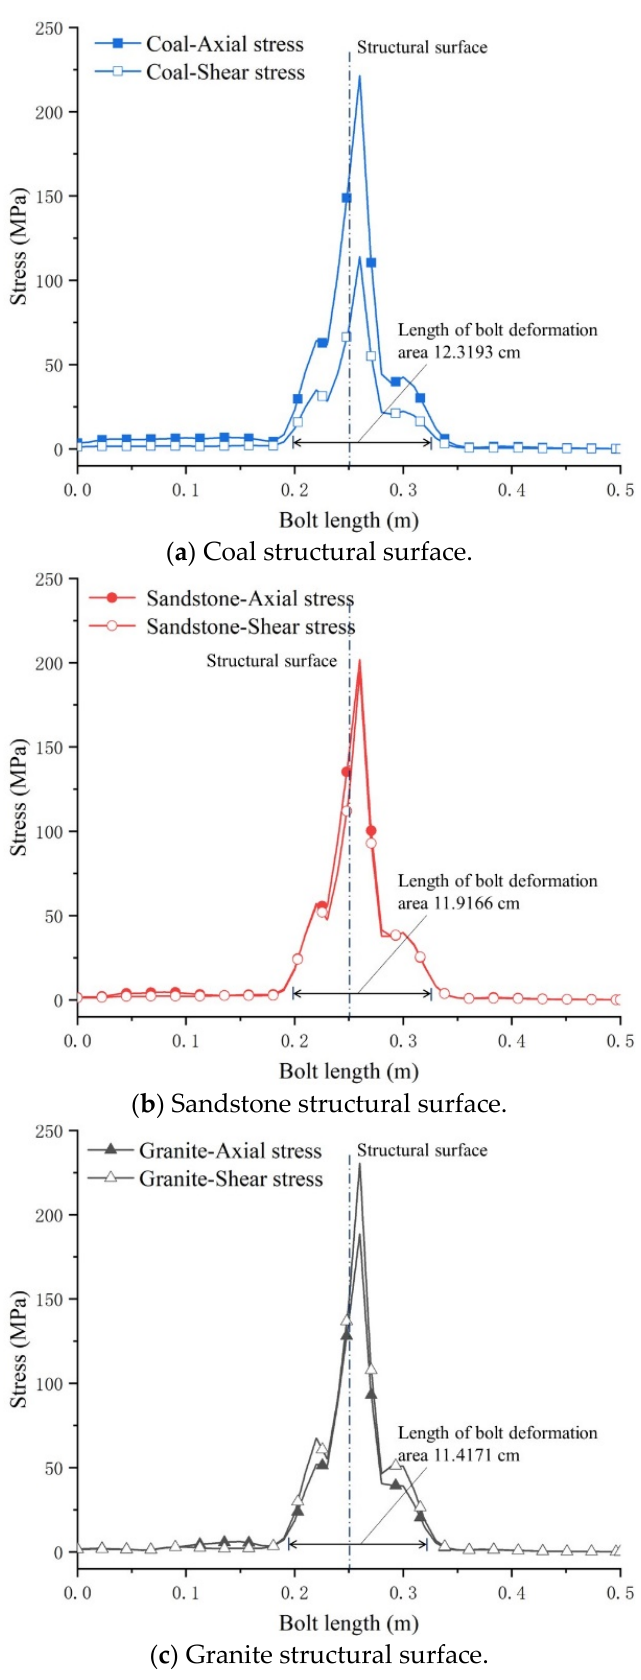
Figure 12. Stress distribution curve along the length of the bolt when it yielded.